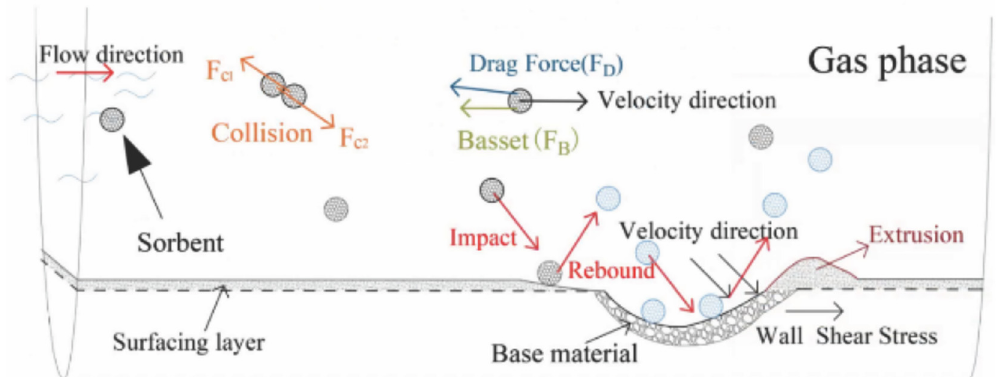
Fig. 3. Failure mechanism diagram of